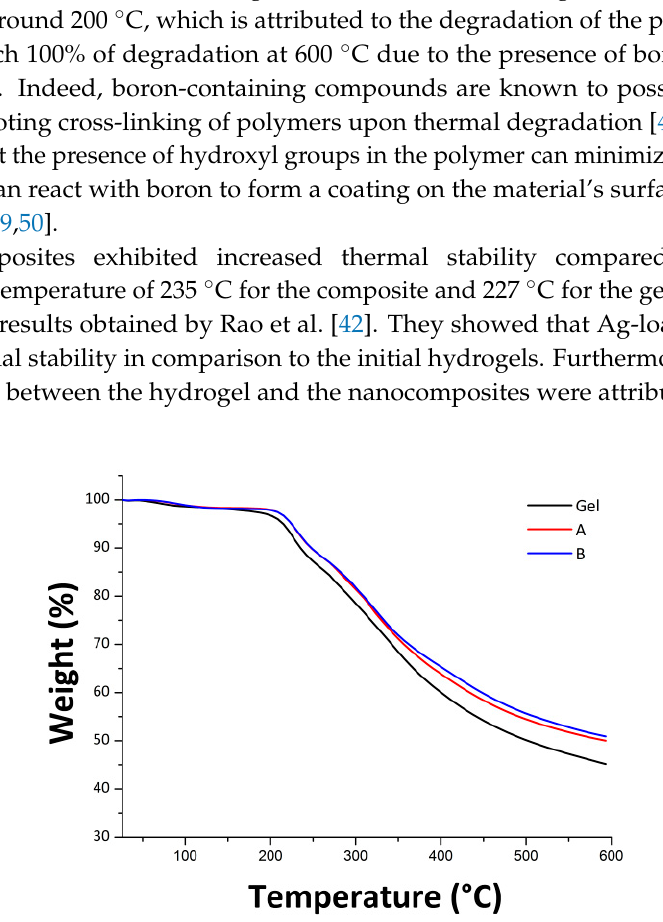
Figure 10. TGA curves of the gel and the resultant nanocomposites.